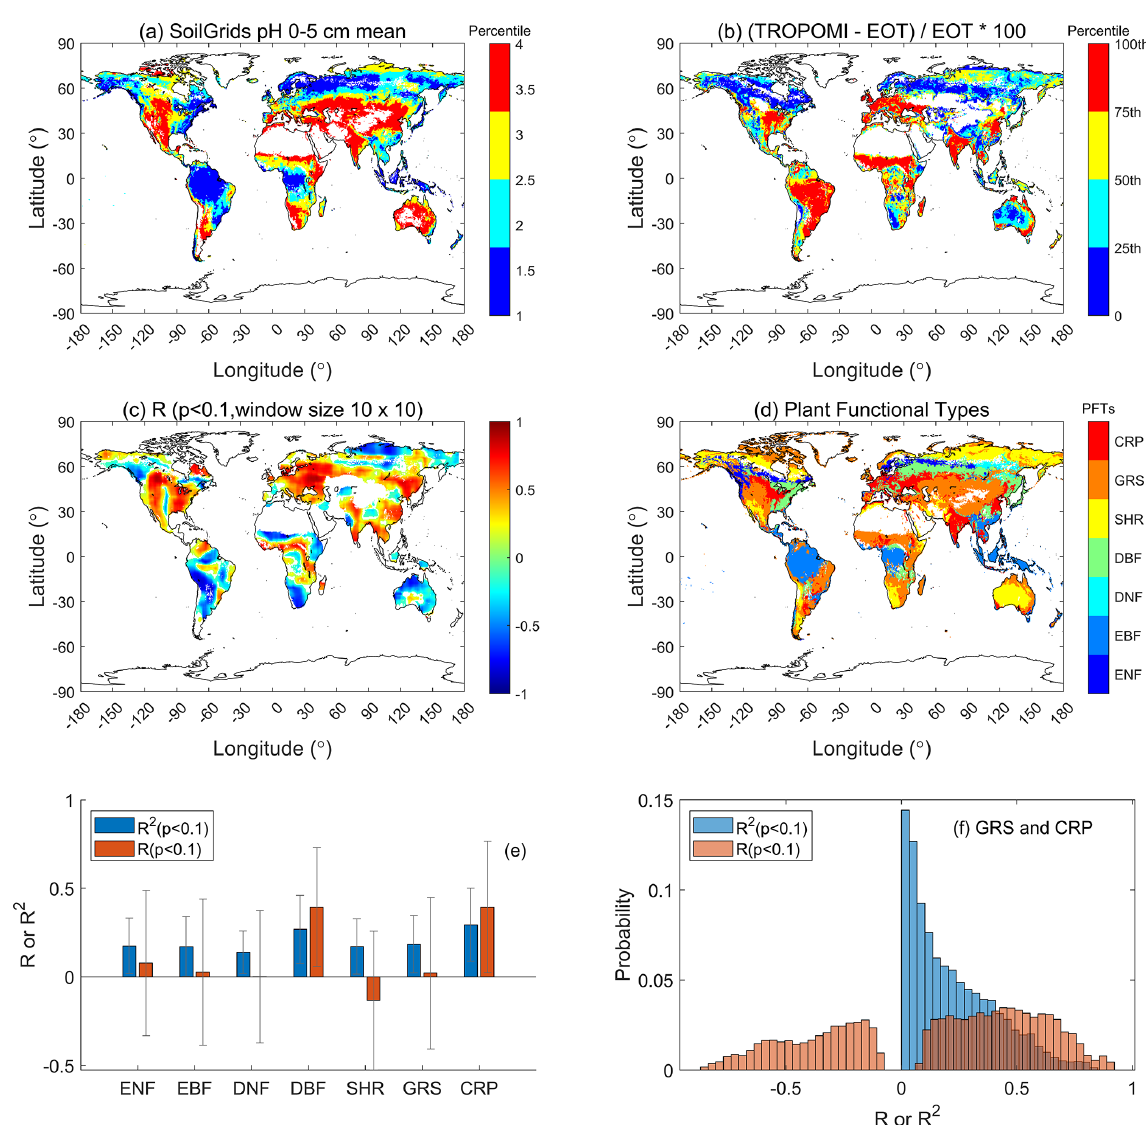
Figure 5. Soil pH has significant influence on V cmax detected by TROPOMI SIF + LCC at 0.5 ◦ resolution. (a) Soil pH in the top 0–5cm layer, (b) relative difference in V cmax ( (cid:49)V cmax ) between TROPOMI and ecological optimality theory (EOT), i.e., (cid:49)V cmax = (TROPOMI- EOT)/EOT, (c) correlation coefficient ( r ) between soil pH and (cid:49)V cmax within sliding windows of 10 × 10pixels, (d) PFT distribution, (e) summary of mean correlation coefficient r and R 2 values in (c) by PFTs, and (f) histograms of r and R 2 values in (c) for grassland (GRS) and cropland (CRP). In 40.3% of GRS and CRP pixels, (cid:49)V cmax is positively and significantly ( p< 0 . 1) correlated with soil